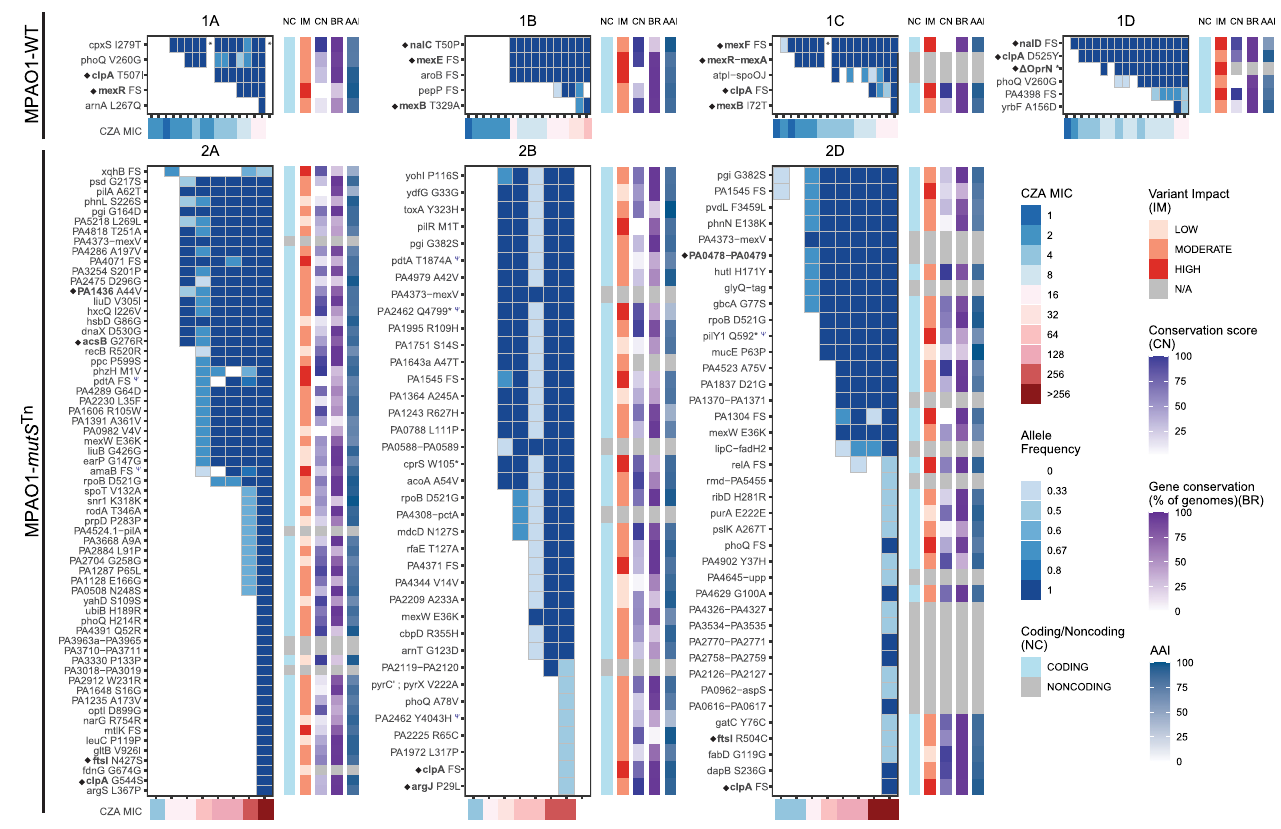
Fig 2. Wild-type lineages demonstrated mutations in canonical resistance genes, while MMR-deficient lineages developed mutations in genes not previously associated with cephalosporin resistance. Fixed variants are plotted versus passage (horizontal axis tick marks) and CZA MIC ( μ g/mL), with a filled tile indicating presence of the variant at the corresponding passage. The shade of blue represents the proportion of isolates (allele frequency) in a given passage carrying the corresponding variant. Up to 3 isolates per lineage per passage underwent WGS. The sidebars to the right of each plot represent functional characteristics of the variant and its protein targets as follows: coding/noncoding (NC) variant; variant impact (IM) as predicted by SnpEff; conservation score (CN) as relative conservation of a mutated AA position within each protein defined as a within-CDS percentile of the Jensen–Shannon divergence scores calculated over a set of 100 Pseudomonas genomes; breadth (BR) as the percentage of 100 Pseudomonas genomes in which the CDS is present; average AAI of the CDS with respect to its orthologs. Genes marked with a C symbol were also mutated in the no antibiotic control experiments. Genes marked with a diamond ◆ are those for which experimental evidence supports a role in third generation cephalosporin resistance. An asterisk ( � ) represents a passage with no sequenced isolates. FS = Frameshift variant. Δ OprN = 7-kb deletion including the oprN gene (partial deletion of mexF , oprN , PA2496, PA2497, PA2498 ( yahD ), PA2499 ( ykoA ), PA2500 ( cynX ), PA2501 and part of PA2502; PAO1 Reference coordinates 2,812,525–2,819,849). CZA MIC was determined by E-test. The underlying data to generate this figure can be found in S2 Data. AAI, amino acid identity; CZA, ceftazidime/avibactam; MMR, mismatch repair; WGS, whole-genome